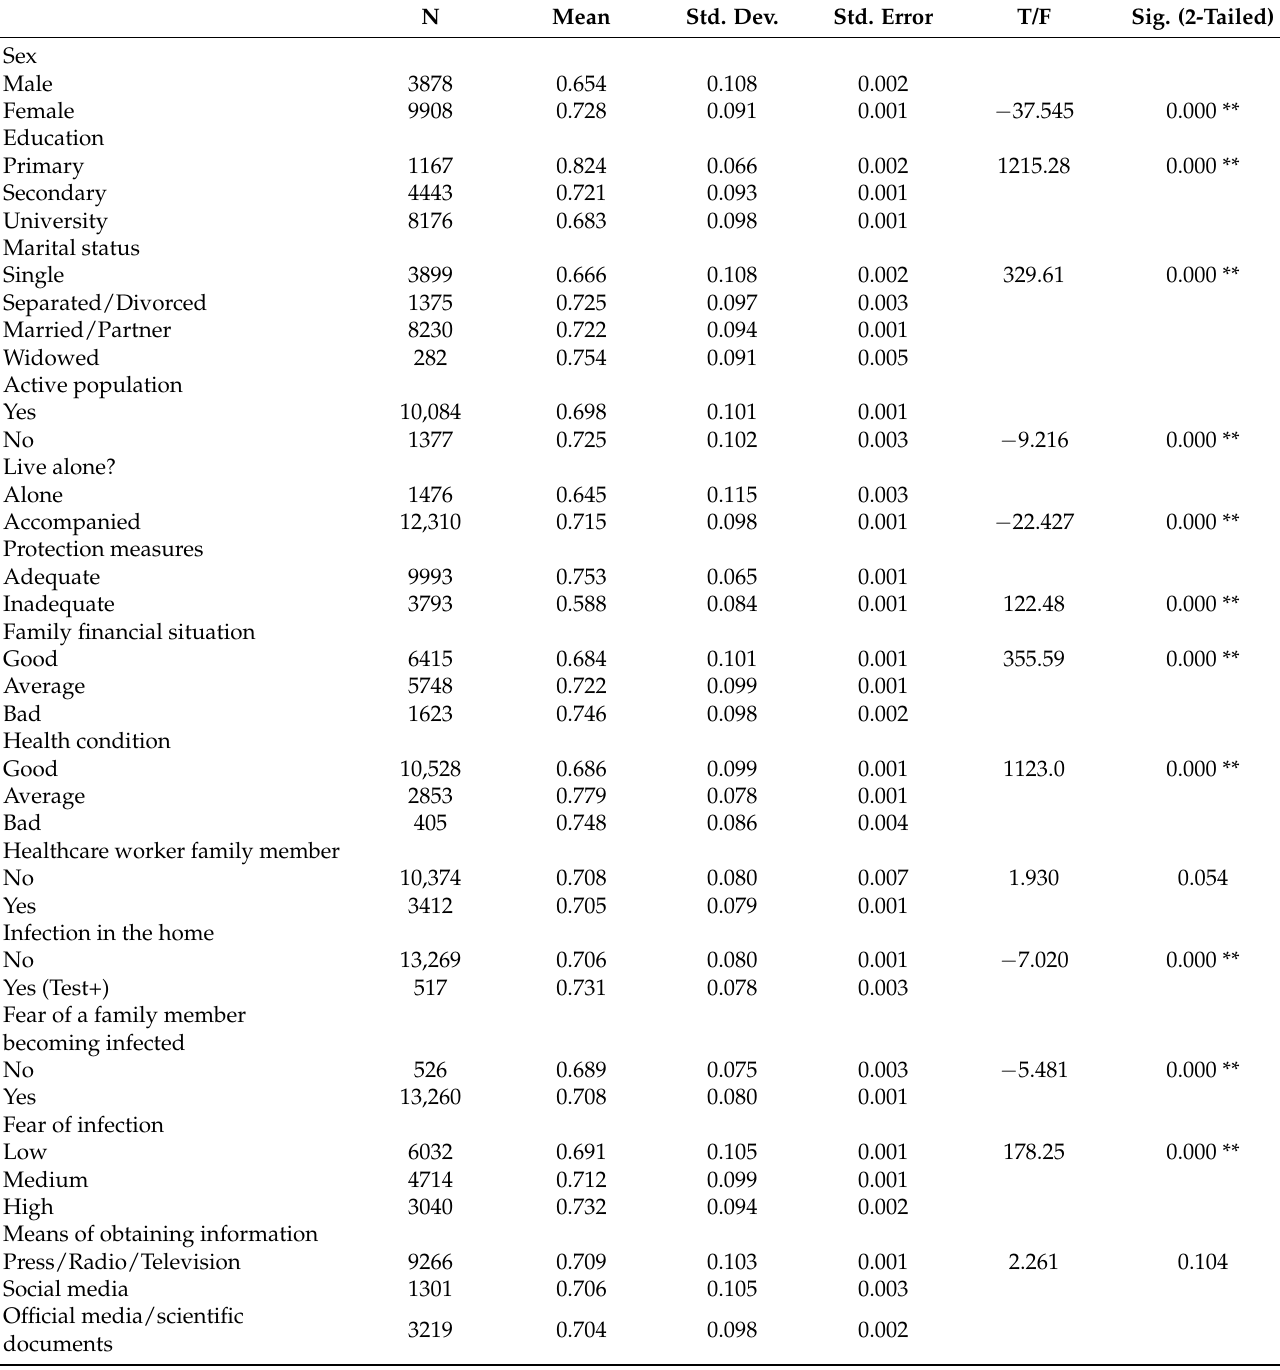
Table 4. Comparison of means/ANOVA for certain subgroups regarding the probability of fear of